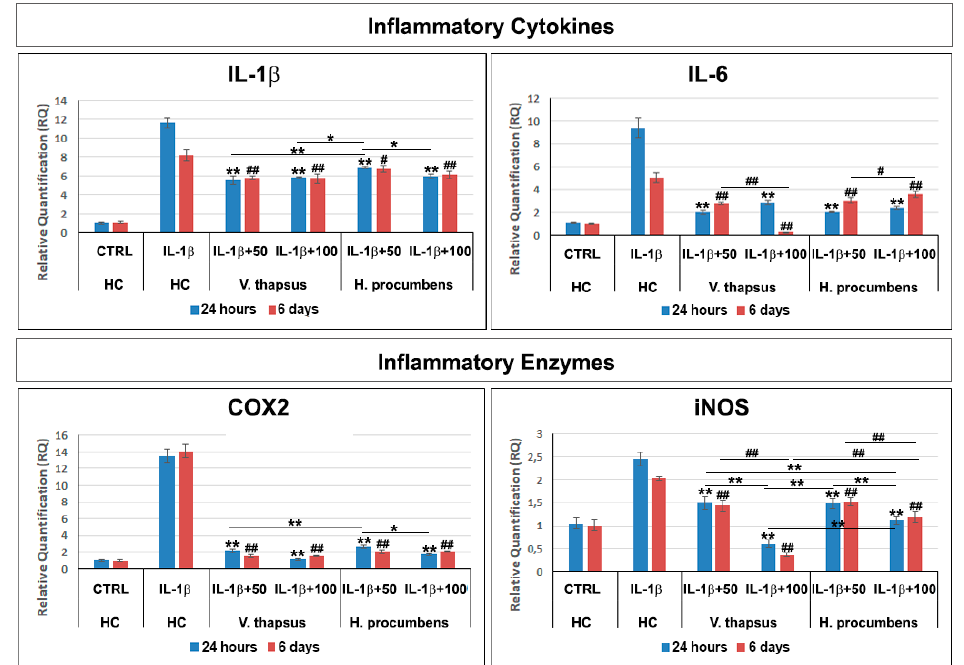
Figure 5. Effects of V. thapsus and H. procumbens treatment on IL-1 β -induced expression levels of inflammatory cytokines and enzymes. Data are represented as the means ± SD of three independent experiments. ANOVA test p -values were reported ( p < 0.0001) and (**, ## p < 0.01 and *, # p < 0.05) indicate significant differences between the two groups, as reported by the Holm post hoc test.